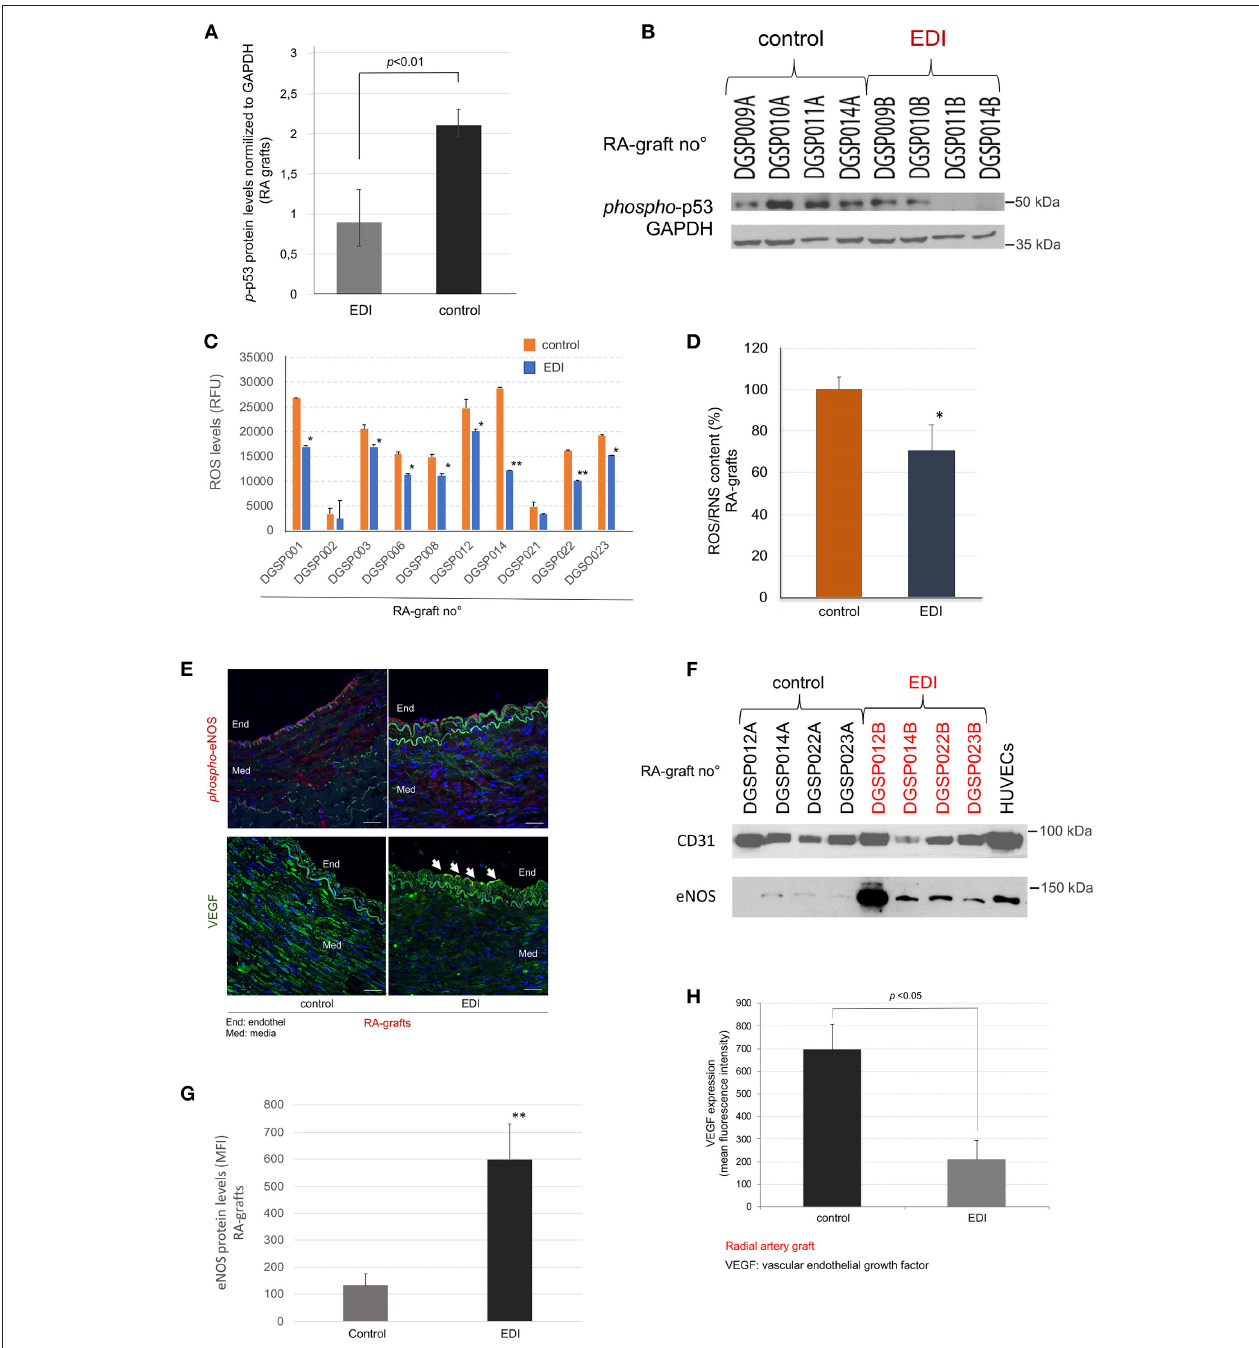
FIGURE 3 | EDI treatment reduced ROS/RNS mediated cell defense. p -p53 mediated induction of cell apoptosis measured by Western blot (WB). (A) Statistic calculation of p-p 53 normalized to internal control GAPDH after EDI or RL treatment. (B) Representative WB is shown. RA graft samples (RA graft no ◦ ) are given on the top, the last letter indicates treatment (A = RL, B = EDI). (C + D) ROS/RNS measurement by OxiSelect TM in protein extracts of RA samples. (C) The blot shows RA graft no ◦ specific results. * p < 0.05; ** p < 0.01. (D) ROS/RNS content in RA samples calculated relative to control group. * p < 0.05. (E) Representative image of phosphorylated-eNOS ( phospho- eNOS, red) and VEGF (green) protein expression stained by IF. Endothelial (End) layer (white arrows). Int, intima. Scale bar, 20 µ m. (F) Representative WB of treated RA samples stained for eNOS and the reference endothelial marker CD31. ECs are given as positive control. The last letter of RA-graft no ◦ indicated the treatment solution (A = RL, B = EDI). (G + H) Statistical analysis for eNOS protein expression (G), and VEGF protein expression (H) measured by IF are given.